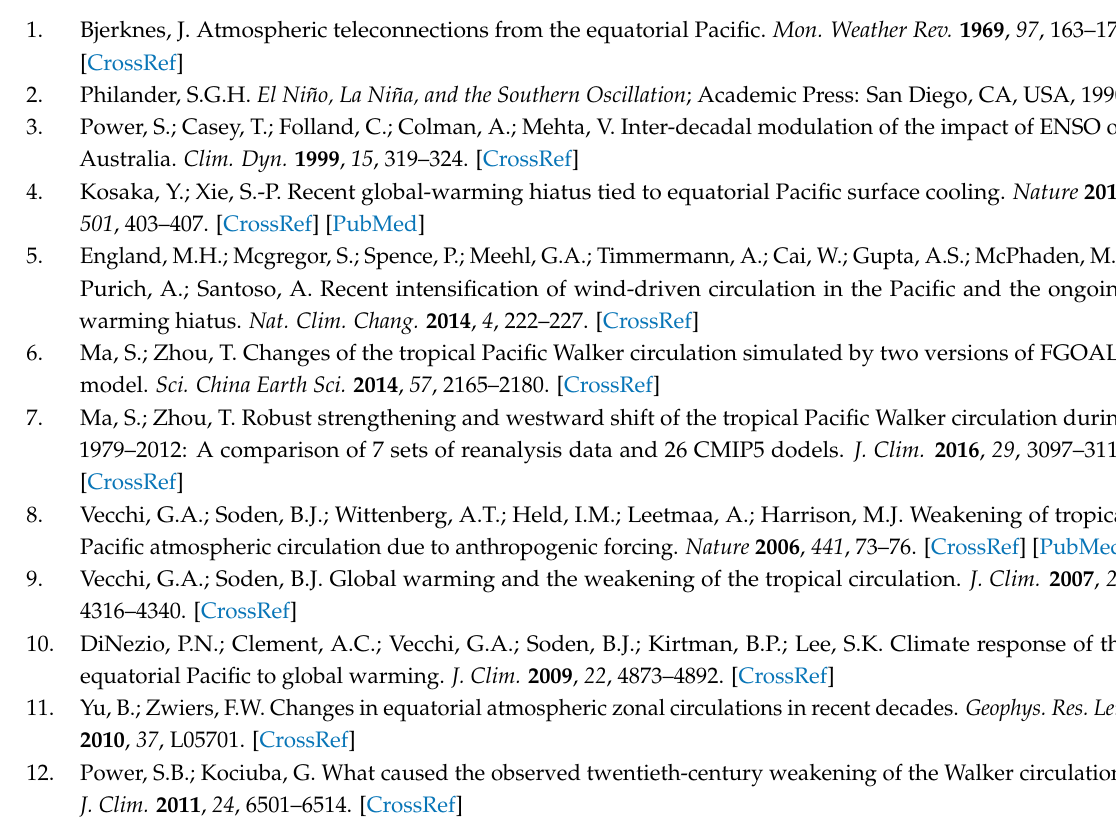
Figure S1: a Mean state (1961–2012) of the annual mean meridionally averaged air temperature (K) between 5 ◦ S and 5 ◦ N using the JRA-55 reanalysis dataset. b homogeneous part of a (global zonal mean of a ). c inhomogeneous part of a ( a minus b ), Figure S2: a Mean state (1961–2012) of the annual mean meridionally averaged ZSF (10 − 6 s − 1 ) between 5 ◦ S and 5 ◦ N using the JRA-55 reanalysis dataset. b homogeneous part of a (global zonal mean of a ). c inhomogeneous part of a ( a minus b ), Figure S3: Contours in a and b : mean state (1961–2012) of the annual mean zonal circulations along the equator (5 ◦ S–5 ◦ N); shading: differences in the annual mean zonal circulations between a the periods 1961–1974 and 1977–1997 and b the periods 1977–1997 and 1999–2012. The changes statistically significant at the 5% confidence level are dotted in purple. The zonal circulations are represented by the MSF (10 11 kg s − 1 ) derived from the method developed by Schwendike et al. [1,2], Figure S4: Same as Figure S3 but for the mean state (contours) of and differences (shading) in the monthly mean of vertically averaged zonal circulations. The zonal circulations are represented by the MSF (10 11 kg s − 1 ) derived from the method developed by Schwendike et al. [1,2], Figure S5: Differences in the zonal circulation (contours; 10 11 kg s − 1 ) and inhomogeneous air temperature (shading; K) along the equator (5 ◦ S–5 ◦ N) between a El Niño and La Niña, b La Niña and El Niño, c the periods 1961–1974 and 1977–1997, and d the periods 1977–1997 and 1999–2012. The zonal circulations are represented by the MSF derived from the method developed by Schwendike et al. [1,2], Figure S6: Time series (1961–2012) of the normalized annual mean tropical PWC intensity indices based on the SLP (defined as the mean SLP over the region (5 ◦ S–5 ◦ N, 80 ◦ W–160 ◦ W) minus the mean SLP over the region (5 ◦ S–5 ◦ N, 80 ◦ E–160 ◦ E); black line), air temperature (defined as in Equation (13) in the main text; blue line), and MSF (defined as the mean value of the MSF over the region (5 ◦ S–5 ◦ N, 140 ◦ W–180 ◦ W, 300–600 hPa); red line), Figure S7: Spatial pattern of the regressed a SST (K), b SLP (hPa), c zonal winds of the zonal circulation at 1000 hPa (m s − 1 ), and d precipitation (mm d − 1 ) against the normalized PWC intensity index based on the MSF for the period 1961–2012. The regression coefficients statistically significant at the 5% confidence level are dotted in